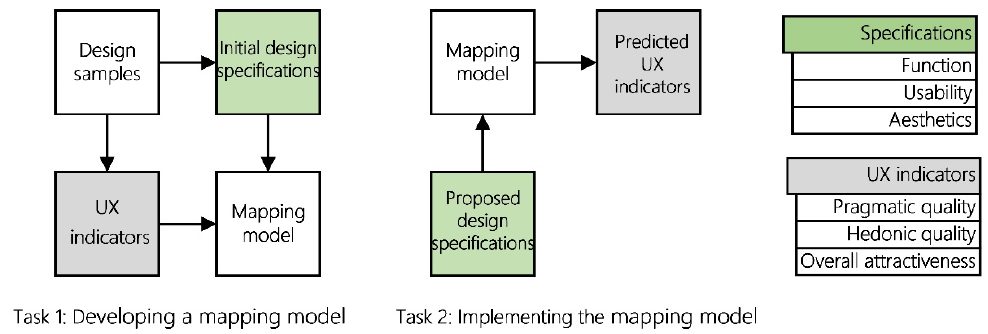
Figure 1. A User ‐ driven Conceptual Design